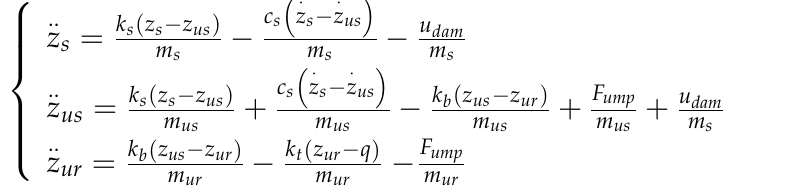
· .. z s is vertical acceleration of sprung mass, z s is vertical velocity where m s is sprung mass, of sprung mass, z s is vertical displacement of sprung mass, m us is stator and residual · .. z us is vertical acceleration of stator and residual unsprung mass, z us is unsprung mass, vertical velocity of stator and residual unsprung mass, z us is vertical displacement of stator .. z ur is vertical acceleration of and residual unsprung mass, m ur is rotor, rim and tire mass, · z ur is vertical velocity of rotor, rim and tire mass, z ur is vertical rotor, rim and tire mass, displacement rotor, rim and tire mass, c s is damping coefficient, k s is spring stiffness, k b is spring stiffness, k t is tire stiffness, q is road excitation and u dam is damping